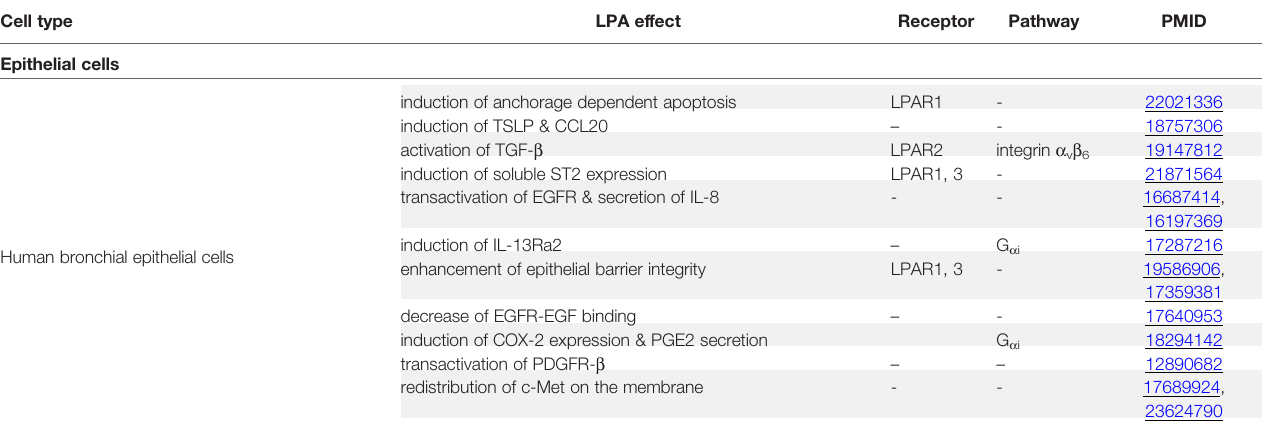
TABLE 2 | Reported Lysophosphatidic acid (LPA) effects on pulmonary, non-immune, cells. Cell